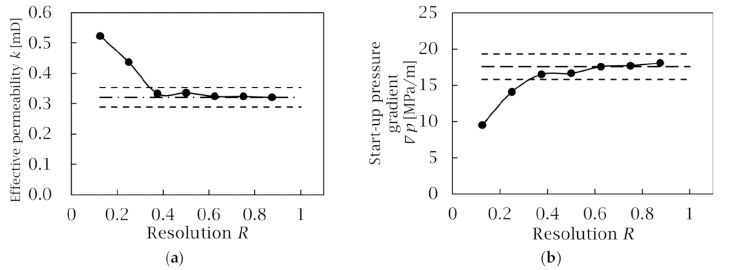
Figure 13. Results of ( a ) effective permeability and ( b ) start-up pressure gradient change with resolution. Long-dashed line is the estimated mean effective permeability (or start-up pressure gradient) and two short-dashed lines cover 10% variation of the mean